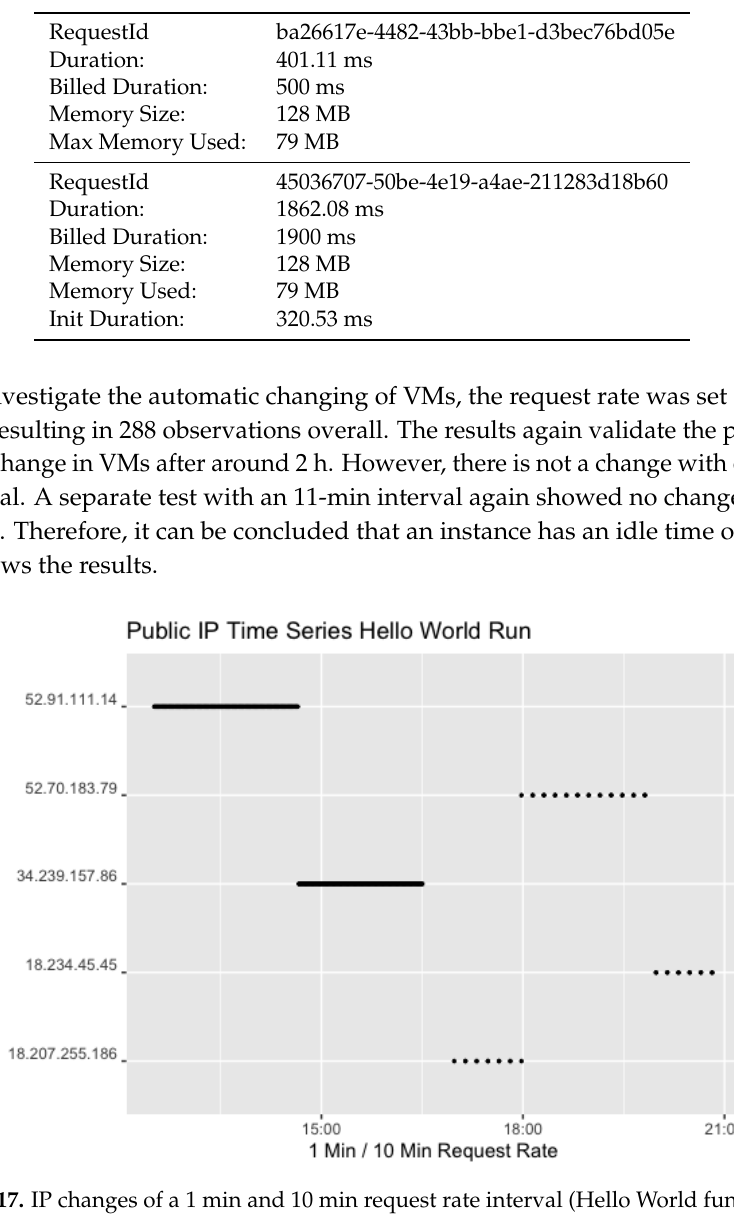
Table 12. Example Cold and Warm Start Request.